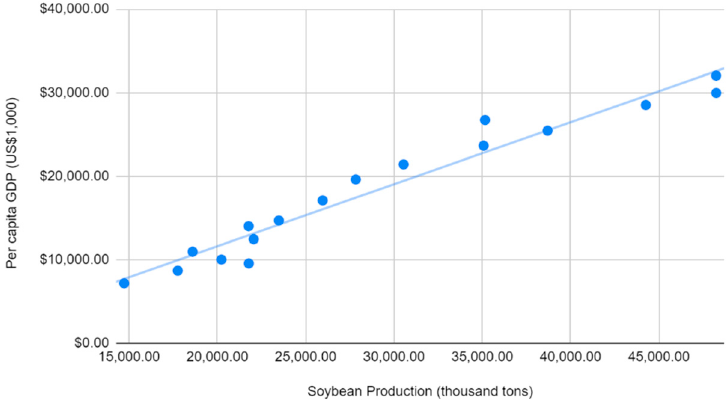
Figure 12. Correlation chart: per capita GDP and soybean production. Prepared by the authors.